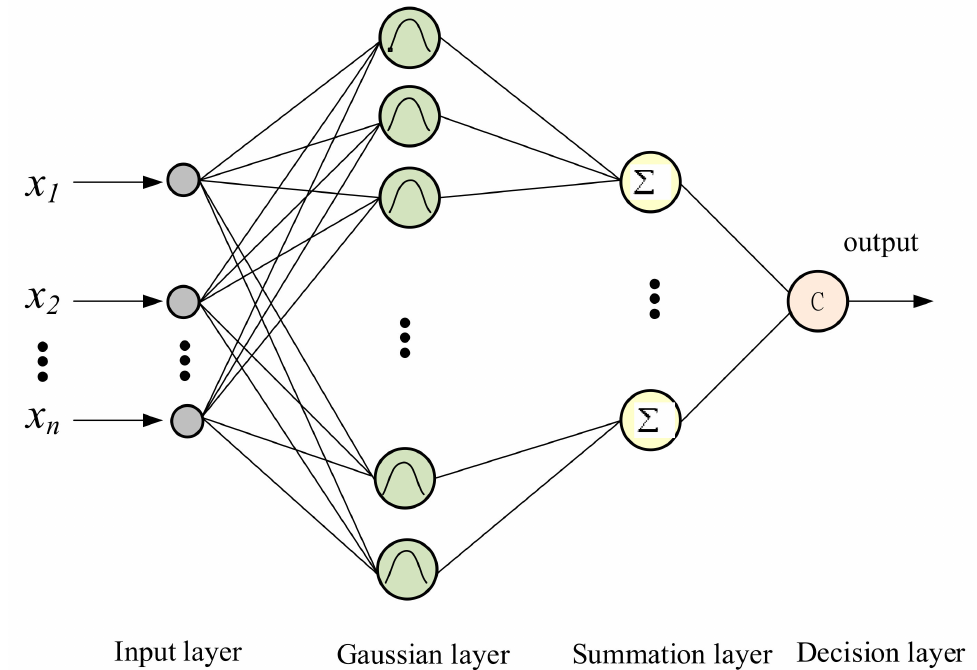
Figure 2. Architecture of a standard probabilistic neural